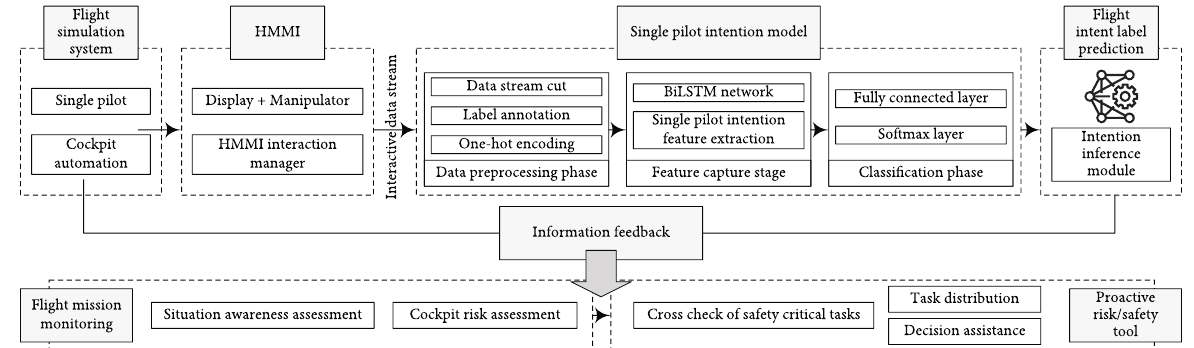
Figure 3: The technical scheme block diagram for single-pilot intention model.